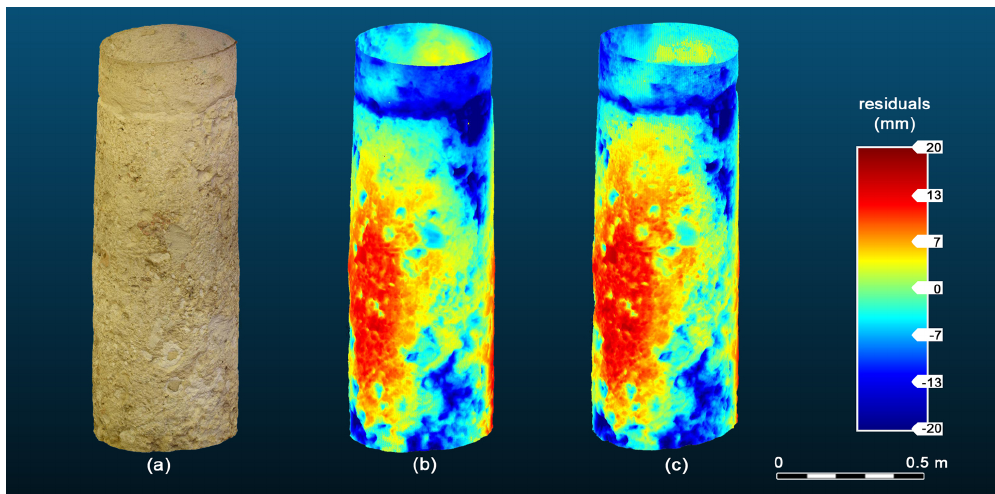
Figure 7. Detail of the body of the column object of this study. (a) 3D model derived from the synergistic application of CRP and TLS; (b) geometrical residuals (m) obtained by comparison of the CRP 3D model with the reference shape of a regular cylinder; (c) geometrical residuals (mm) obtained by comparison of the TLS 3D model with a regular cylinder. The comparison between the two techniques shows there are no significant differences between TLS and CRP. The differences are visible in the small details: in panel (c) the more prominent parts are more visible (graphic elaboration with JRC 3D Reconstructor ® and CloudCompare, 2020).